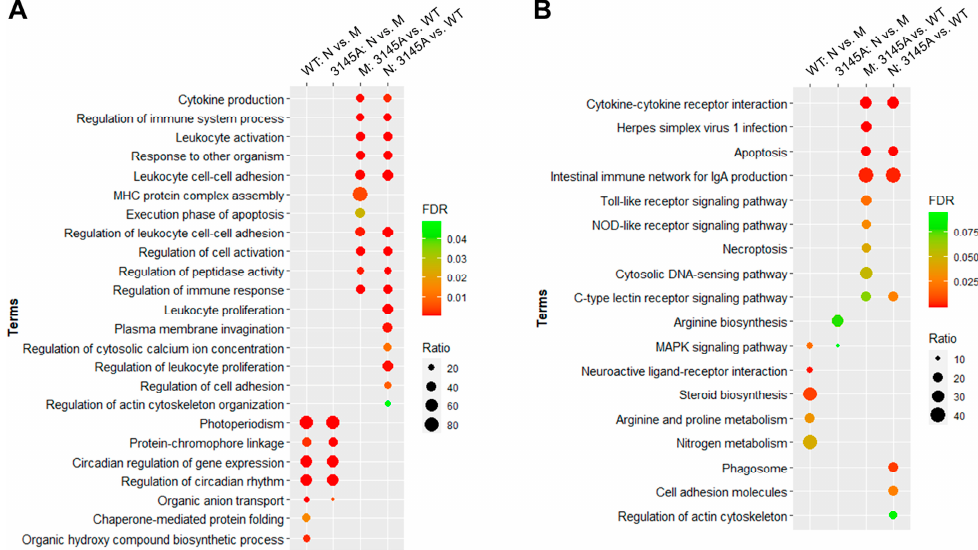
Figure 8. Top GO biological process and KEGG pathway enrichments for the DEGs. ( A ) Top GO biological process terms. ( B ) Top KEGG pathway terms. FDR, false discovery rate; ratio, proportion of the DEGs to all the genes associated with the corresponding functional term. Only terms with FDR < 0.05 are shown.